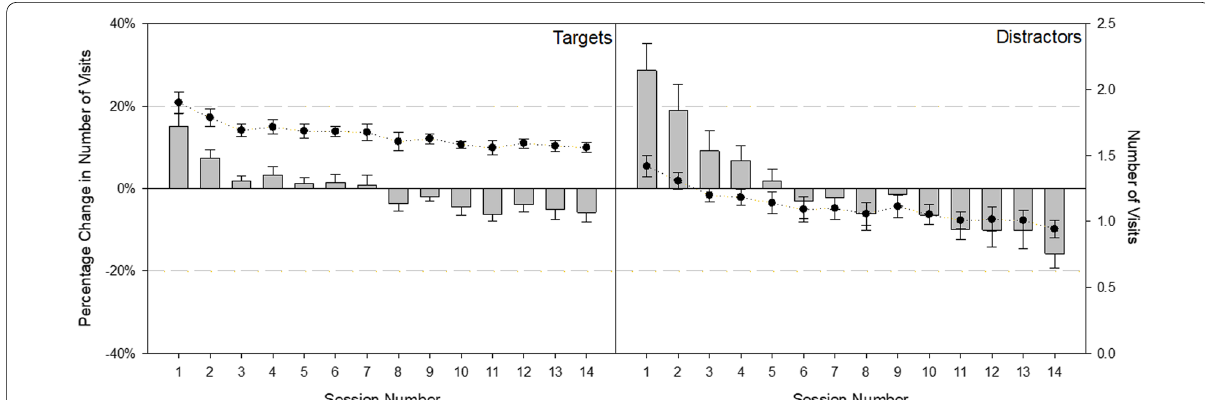
Fig. 6 Average number of visits (circles) and percent change in average number of visits (bars) across sessions for targets (left graph) and distractors (right graph). Error bars reflect 1 standard error ±